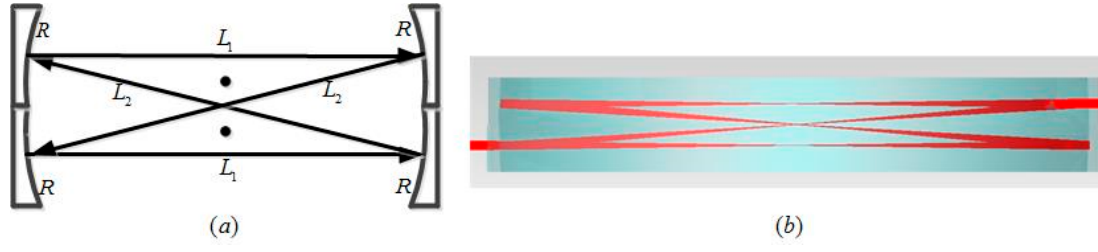
Figure 3. ( a ) Equivalent optical cavity and the corresponding equivalent process of the beam round trip of the DR-CMPC, where L 1 is the path-length of the first and third pass in the four-pass-cycle, and L 2 is the path-length of the second and forth pass in the four-pass-cycle; ( b ) The simulation example of first eight passes within DR-CMPC with R = 125 mm, p = 150, q = 73 and c = 4.4 mm , to verify the equivalent.